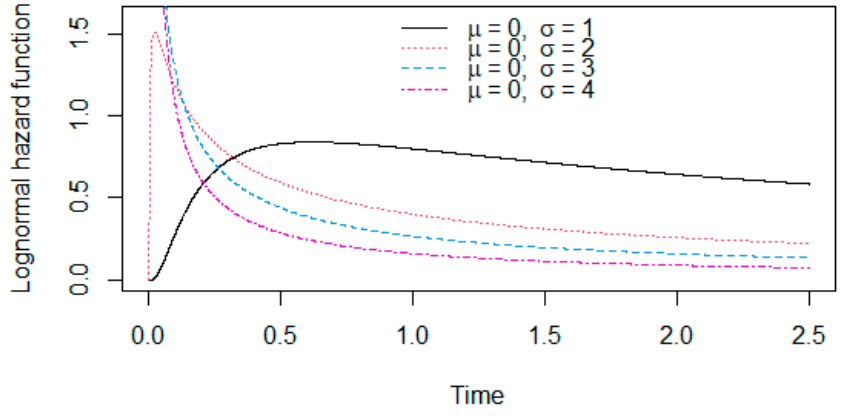
Figure 4. Hazard functions of the lognormal distribution with parameters 𝜇 and 𝜎 .